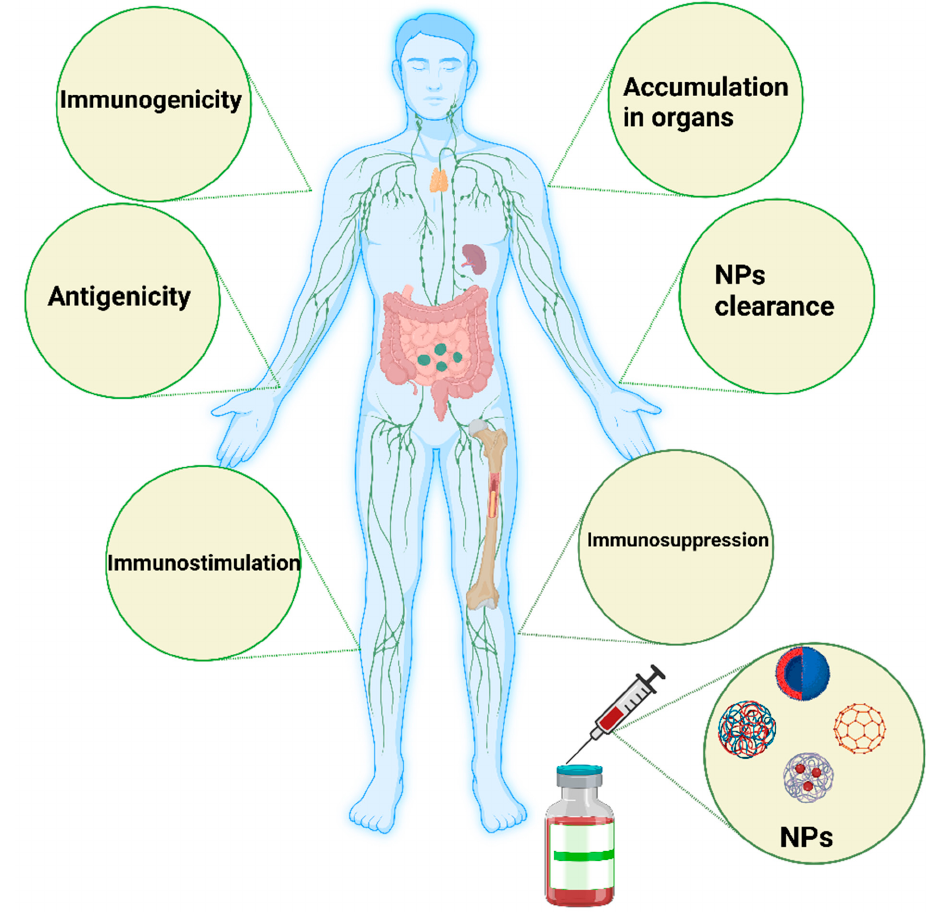
Figure 2. Schematic illustration of the major influence of nanomaterials on the immune system. Nanomaterials can induce immunogenicity, which is the ability of NPs to induce humoral or cell-mediated immune responses, whereas the antigenicity effect of NPs deals with the ability of such materials to react with antibodies or T cells. NPs could be engineered to avoid interactions with the immune system or specifically interact with the immune system to simulate or suppress their effects. In some cases, the immune system stimulation generated by such NPs could manifest as a hyper- sensitivity reaction, anaphylactic shock, or inflammation. In immunosuppression, NPs can have a stimulating effect on immune system components, such as APCs, B cells, and T cells, directly or indirectly. The degradation and clearance of NPs are the main factors contributing to the use of such materials in clinical settings. Tiny NPs below 10 nm are rapidly excreted by the kidney and liver. Particles larger than 100 nm can be eliminated by the mononuclear phagocytic system, such as the lymph nodes and spleen. The image was generated by BioRender.